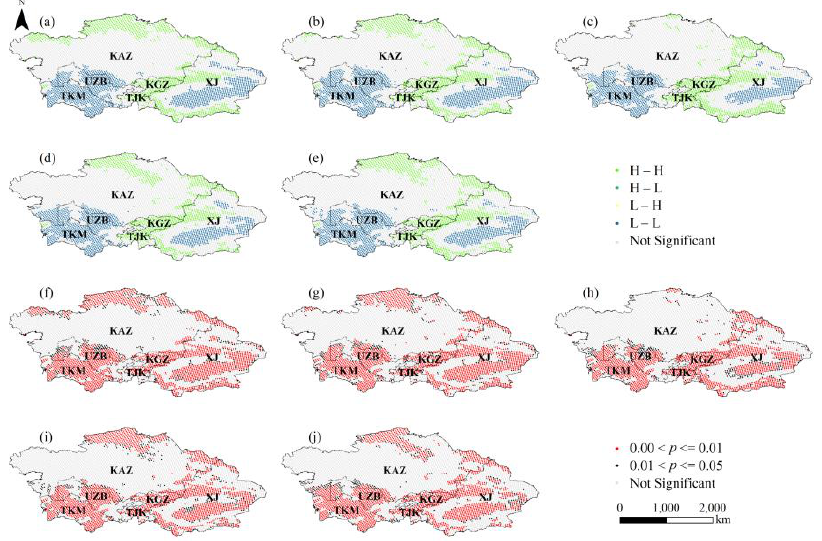
Figure 8. LISA map (( a – e ) and ( f – j ) are the LISA cluster maps and LISA significance maps of 2000, 2005, 2010, 2015, and 2020, respectively).